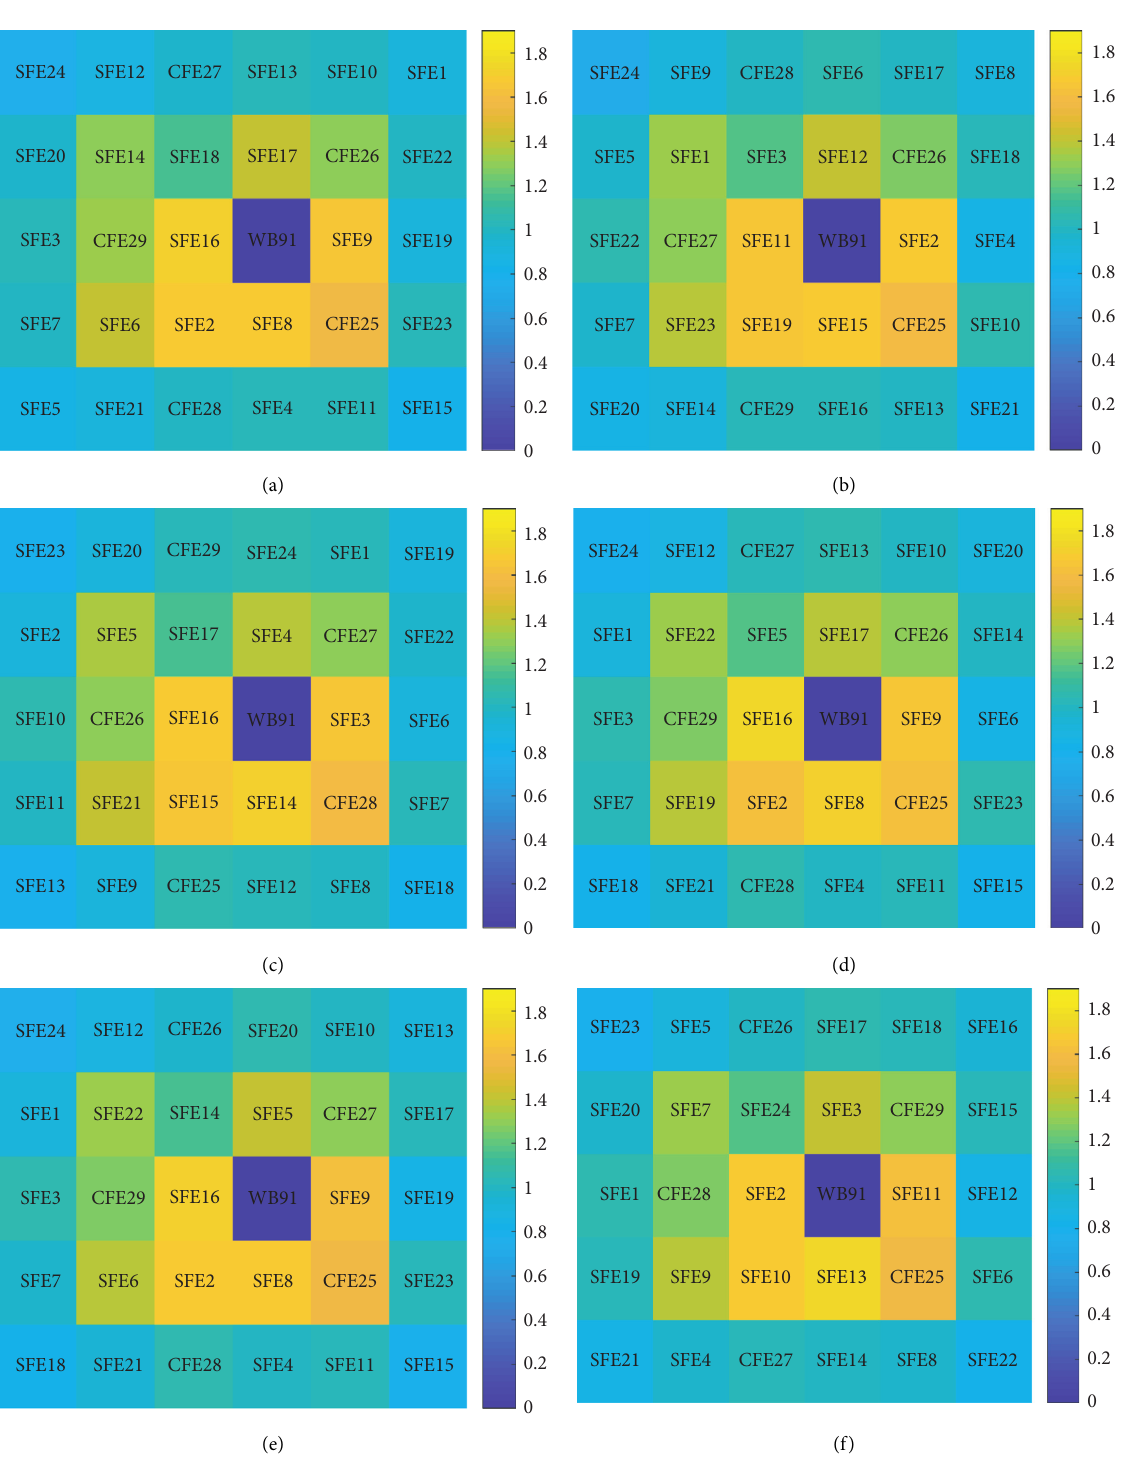
� 7.93086 × 10 13 ( ± 0.00025). th